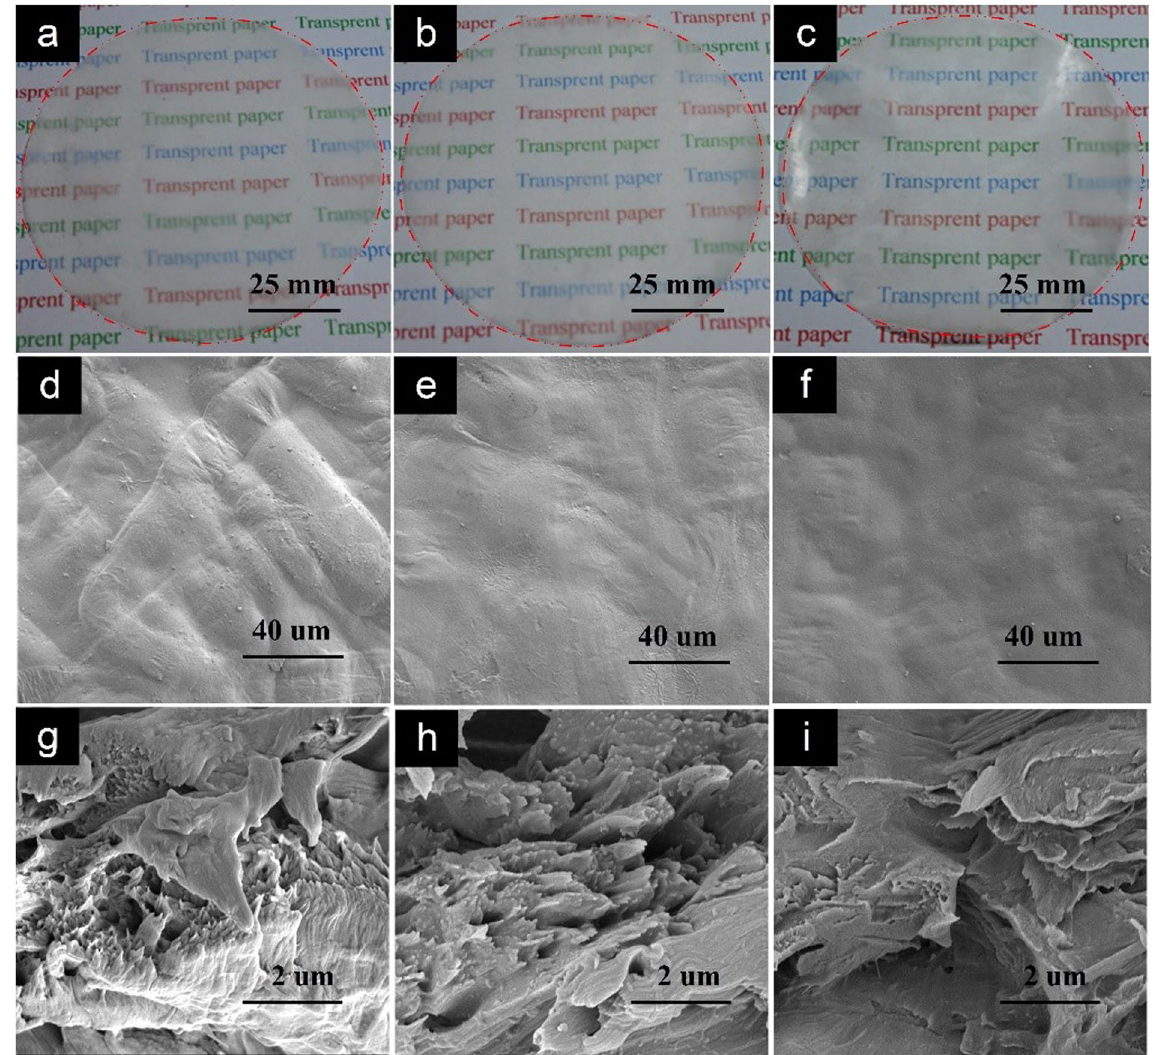
Figure 3. Digital images of nanostructured transparent paper prepared with the repetitious ILs-polishing process by the first ( a ), the second ( b ) and the third time ( c ) respectively. SEM images of the surface ( d – f ) and the cross-section ( g – i ) of resulting paper responding to the ILs-polishing